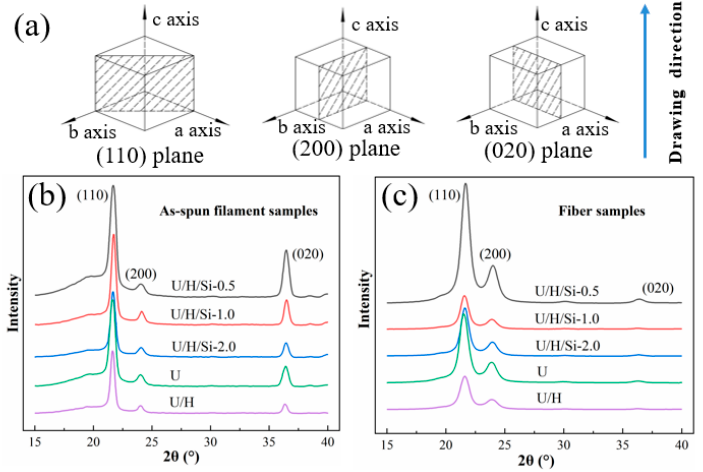
Figure 8. ( a ) © schematic diagram of three diffraction peaks; ( b ) WAXD patterns of as-spun filament samples; ( c ) WAXD patterns of fiber samples.